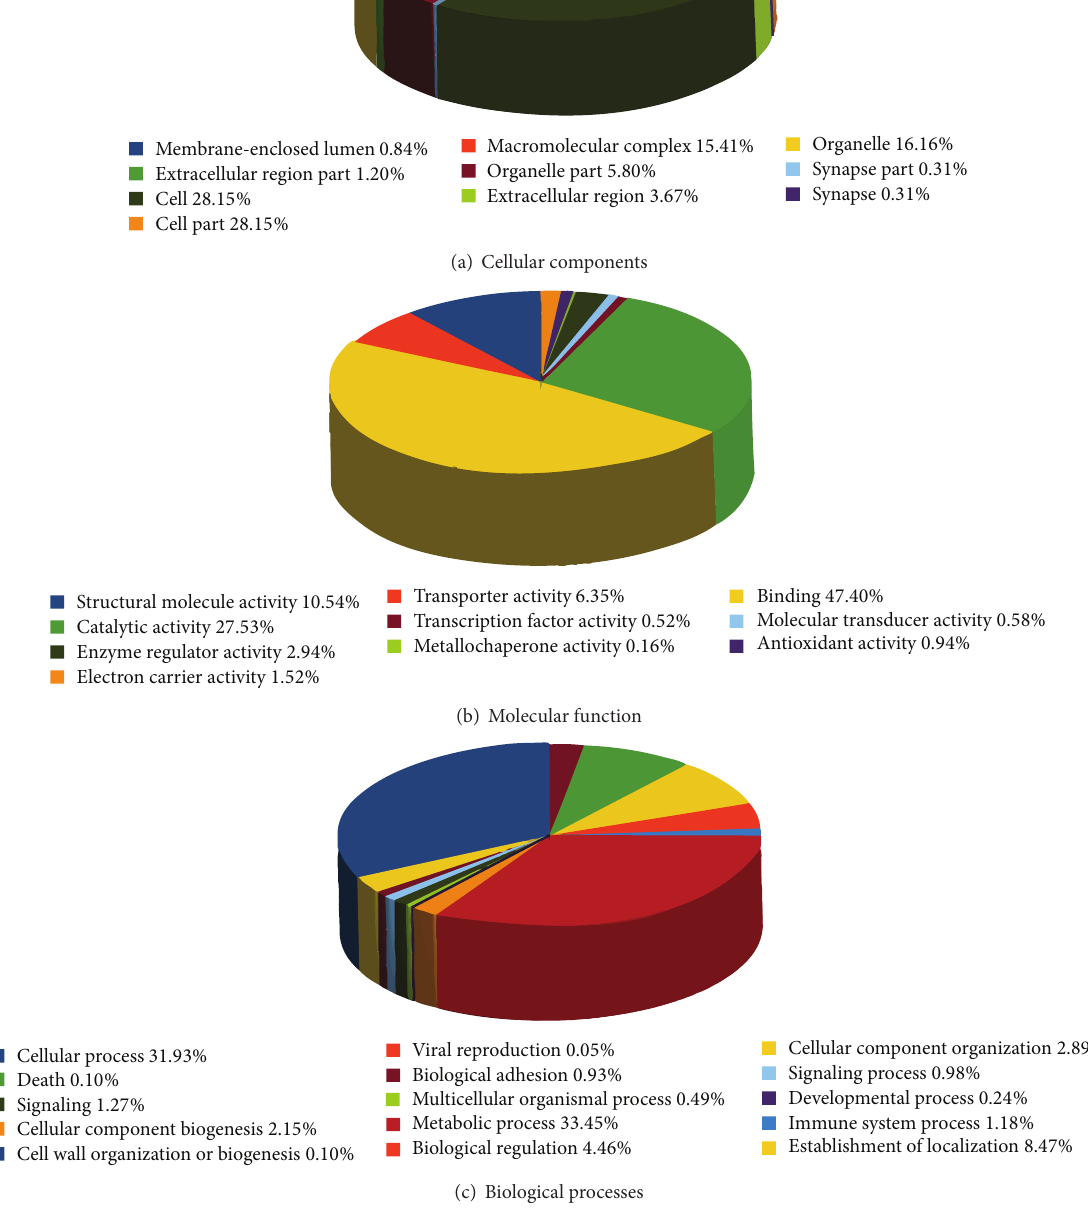
Figure1: Functional categorization ofunigenes with geneontology (GO) termfor the Aphanopus carbo ESTcollection. Theseunigenes results were functionally classified from the six tissues pooled together as percentages under three main functional categories with respective GO Slim terms. Data refer to assemblage derived by implementation of Newbler, Roche 454 sequence analysis